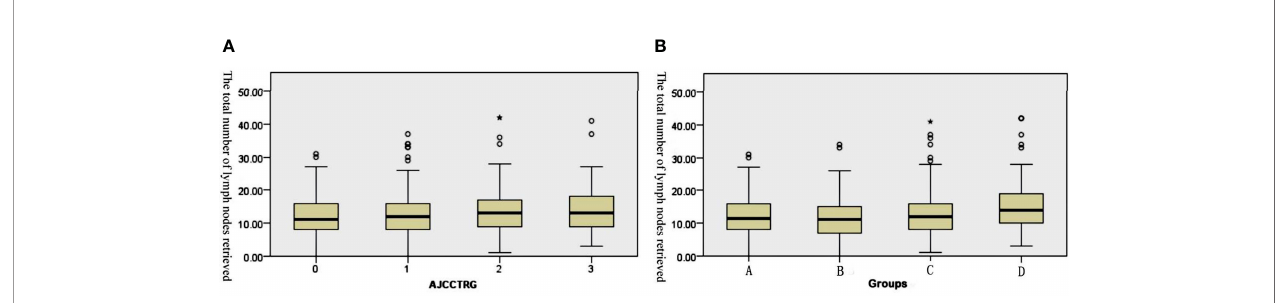
FIGURE 1 | Box plots of the number of retrieved lymph nodes. (A) The retrieved lymph nodes in the four stage groups after the operation. (B) The retrieved lymph nodes in the different TRG groups after